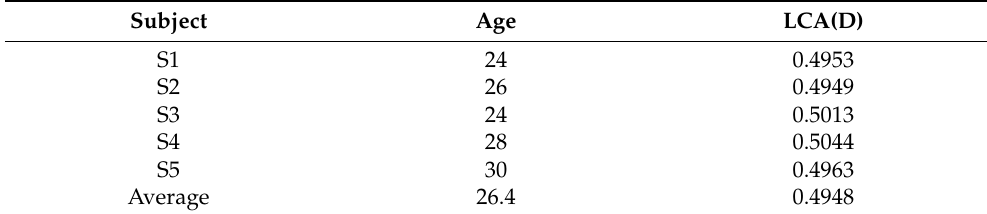
Table 2. Longitudinal chromatic aberrations between blue pulse width (440–480 nm) and red pulse width (580–640 nm)